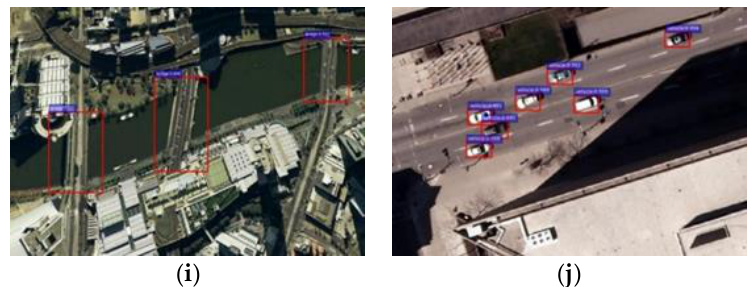
Figure 9. Object detection examples on NWPU VHR-10 dataset with the proposed CBFF-SSD algorithm framework. ( a ) Airplane; ( b ) ship; ( c ) storage tank; ( d ) baseball diamond; ( e ) tennis court; ( f ) basketball court; ( g ) ground track field; ( h ) harbor; ( i ) bridge and ( j ) vehicle.